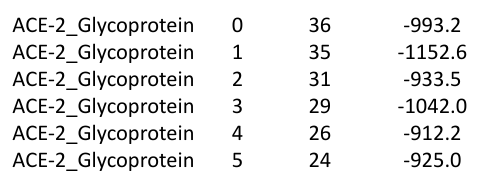
Table 2. Binding energy of ACE-2 with SARS-CoV-2 spike glycoprotein Molecular Complex Cluster Member Lowest